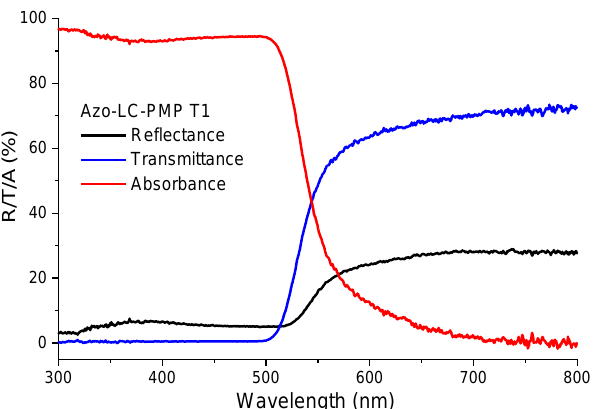
Figure 6. Spectral characterization of LC81: reflectance (black line), transmittance (blue line), and absorbance (red line).